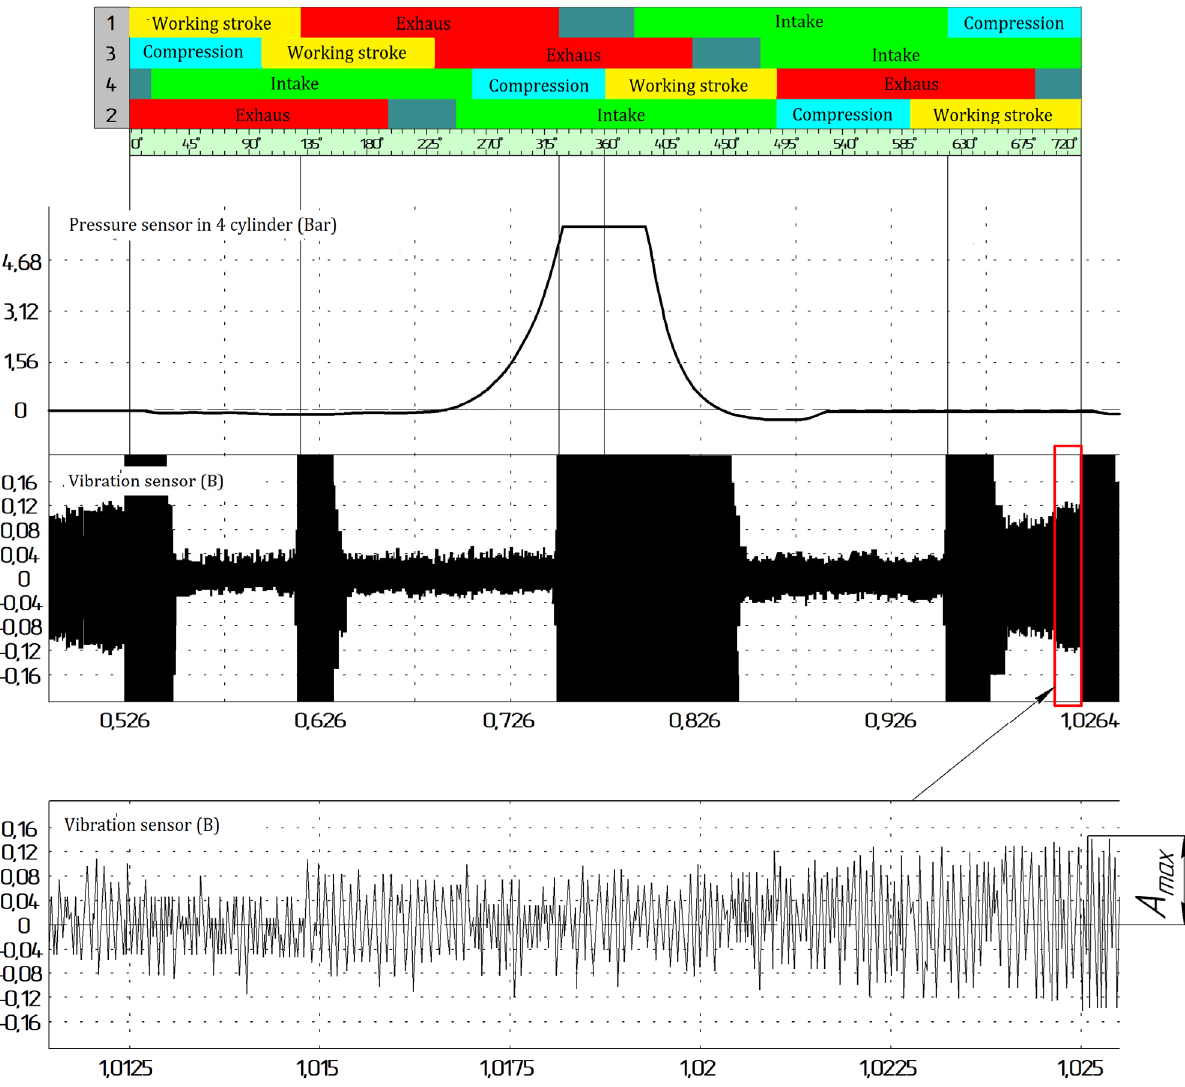
Figure 10. An oscillogram of the vibration sensor during the compression stroke for a VAZ 21083